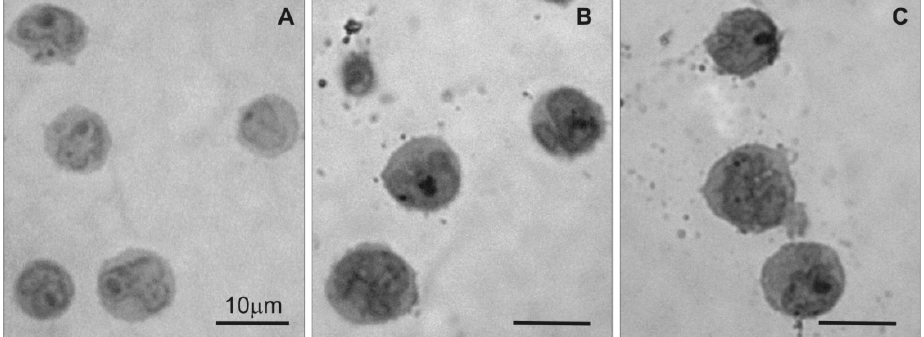
Figure 2. Light microscopy of semi-thin sections of 1301 cells: ( A ) untreated cells, ( B ) cells treated with CRD13 dendrimer at 2.5 µmol/L, ( C ) cells treated with CRD27 dendrimer at 5 µmol/L. Scale bar = 10 µm.